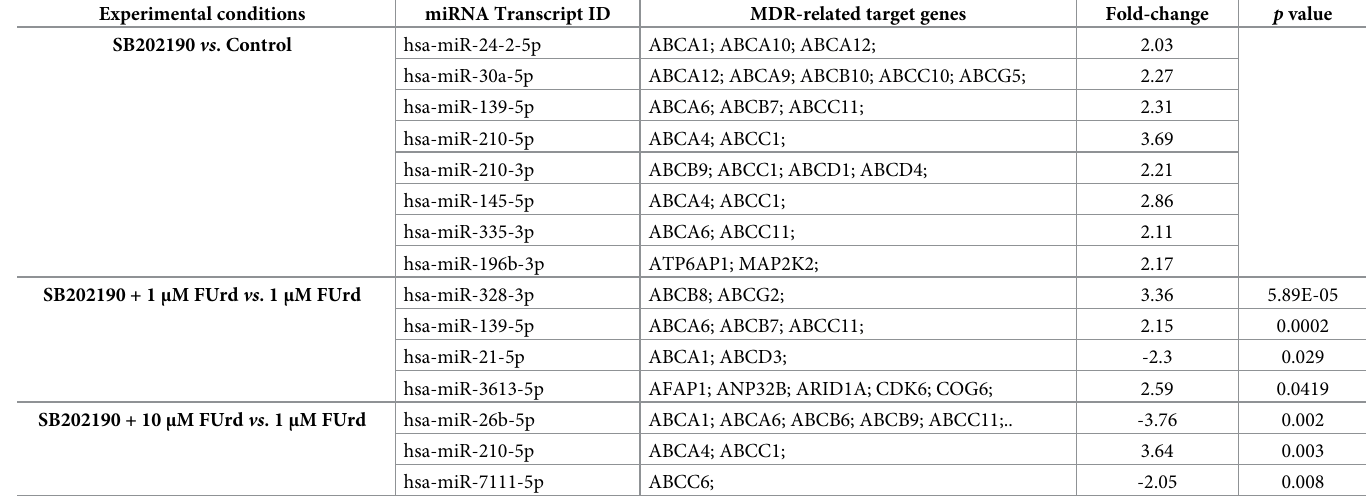
Table 1. Profiling of the top differentially dysregulated drug resistance-associated miRNA in AML stem cell line KG1a exposed to SB202190 p38 MAPK inhibitor and to 1–10 μ M FUrd. Experimental